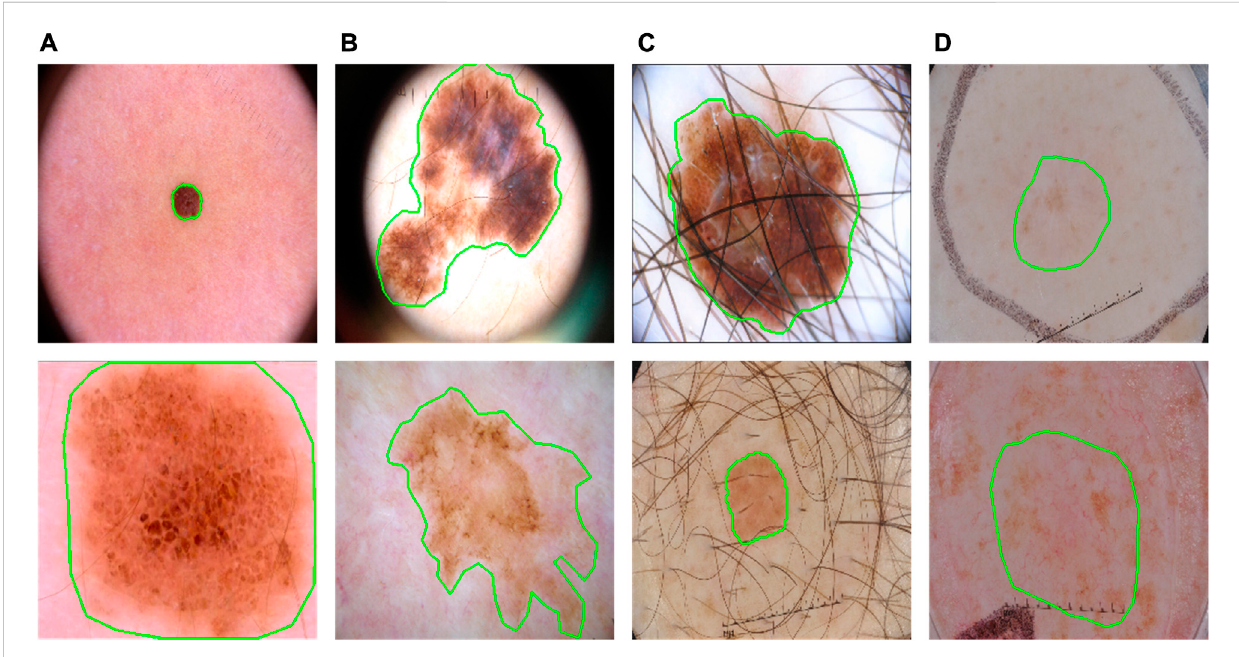
FIGURE 1 Some typical cases in dermoscopic images for skin lesion segmentation. (A) Large variety in sizes; (B) large variety in shapes; (C) hair occlusion; (D) low contrast between lesions and